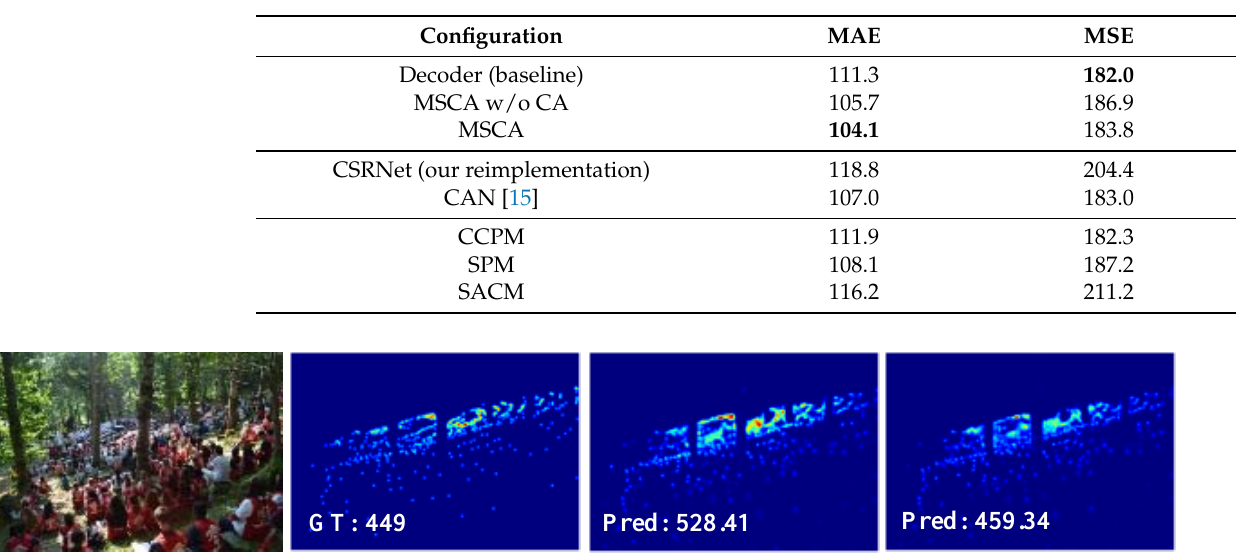
Table 5. Comparisons of our proposed method with different architecture changes on the UCF- QNRF dataset.